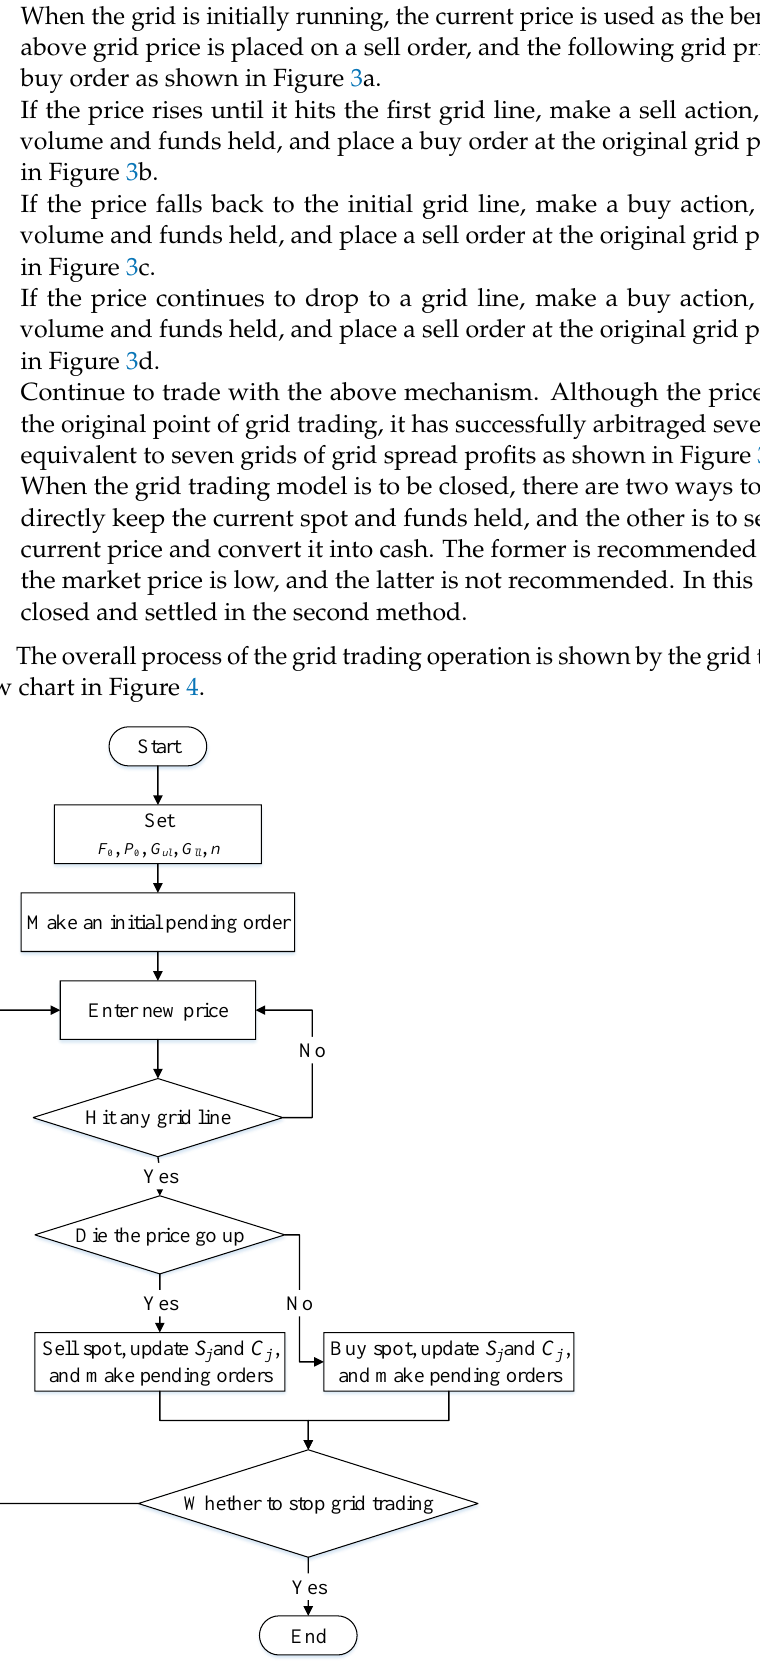
Figure 4. Grid trading operation flow chart.